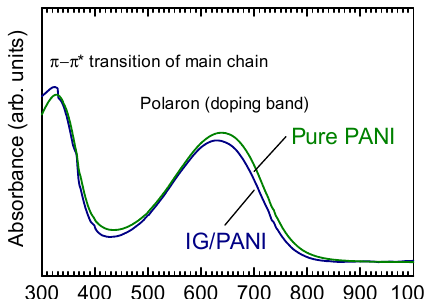
Figure 1. Ultraviolet–visible absorption spectra of pure PANI and IG–PANI.